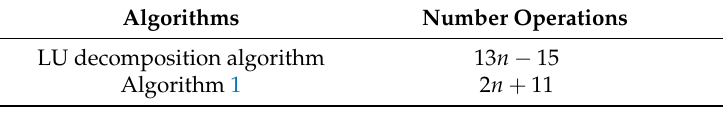
Table 1. Comparison of the total number operations for determinant of A .